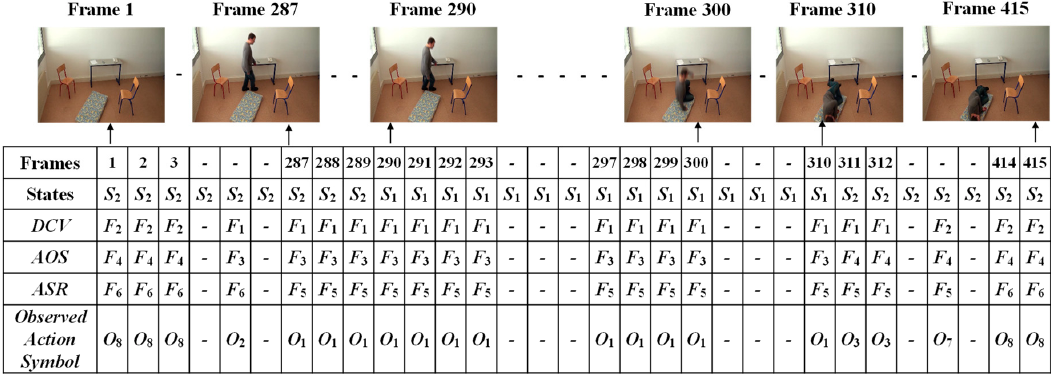
Figure 14. Observations for independent action symbol O for Mr. ONE (Video 1).